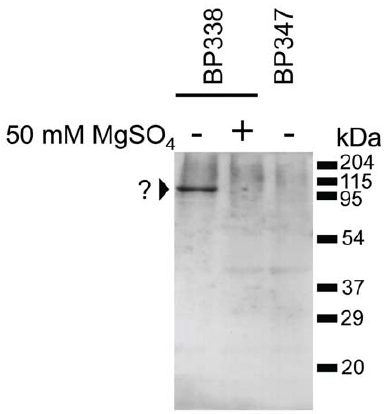
Figure 1. Far-Western analysis showing interaction of C1inh from normal human serum with an unknown B.pertussis factor migrating at ca. 90 to 100 kDa. B. pertussis strain BP338 (wild type) and its isogenic mutant BP347 ( bvgS ::Tn 5 ) were grown without ( 2 ) or with ( + ) Bvg-modulating agent MgSO 4 (50 mM) prior to performing the Far-Western assay using normal human serum as the probe, followed by detection using anti-C1inh antibody.